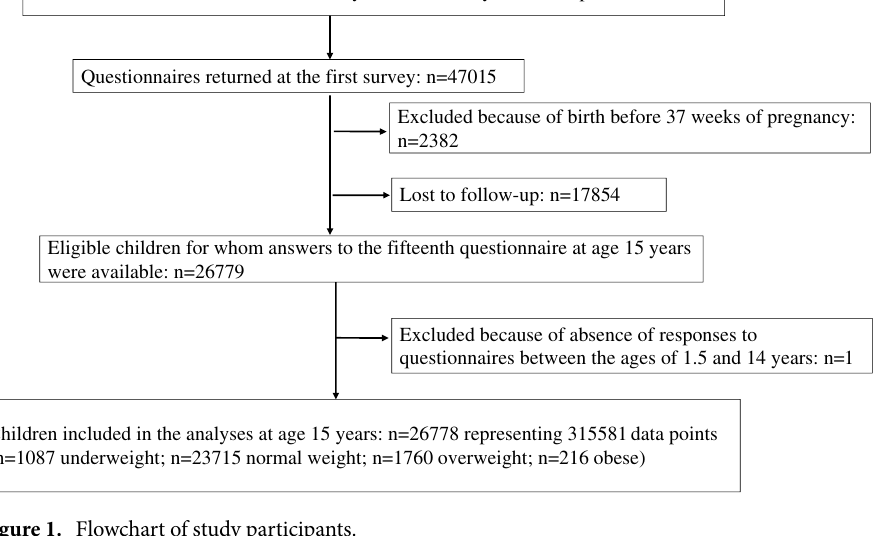
Figure 1. Flowchart of study